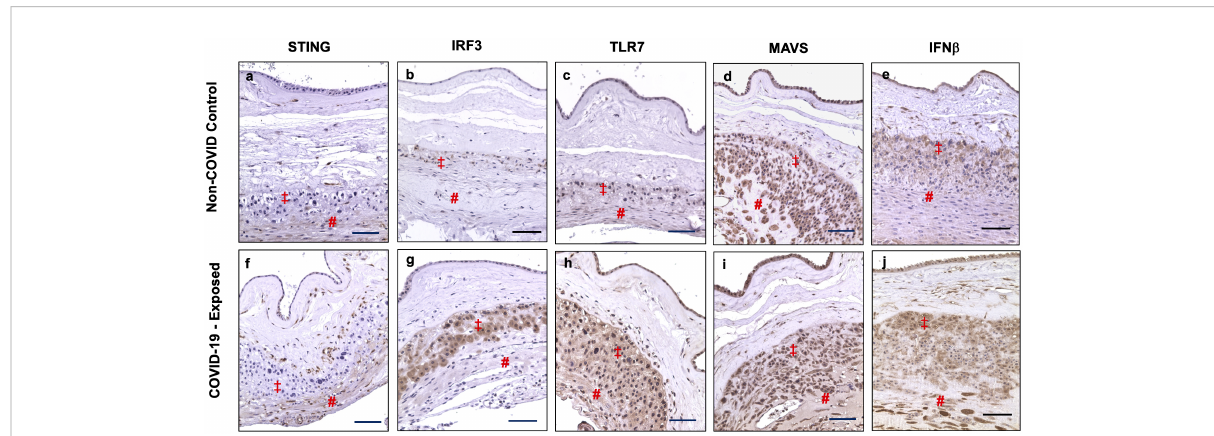
FIGURE 4 STING, IRF3, TLR7, MAVS, and IFN b expression in fetal membrane of placentas with or without exposure to maternal COVID-19 infection. Images a – e show STING, IRF3, TLR7, MAVS, and IFN b expression in fetal membrane from non-COVID control placentas, and images f – j show STING, IRF3, TLR7, MAVS, and IFN b expression in fetal membrane from COVID-exposed placentas. Upregulation of IRF3 in EVTs, and increased STING, TLR7, and IFN b expression in chorionic mesoderm and decidual stromal cells were detected in fetal membrane of COVID-exposed vs. non-COVID control placentas. Increased IFN b expression was also noticed in EVTs in fetal membrane of COVID-exposed placentas. ‡ : EVTs and # decidual cells. Bar =